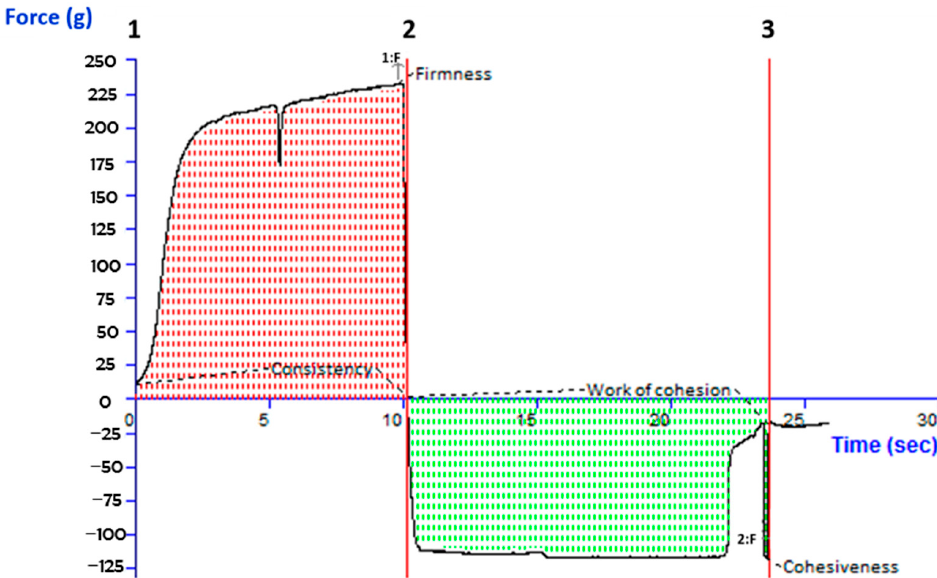
Figure 4. Texture analysis diagram showing firmness, consistency, cohesiveness, and work of cohesion of optimized transethosomal gel.